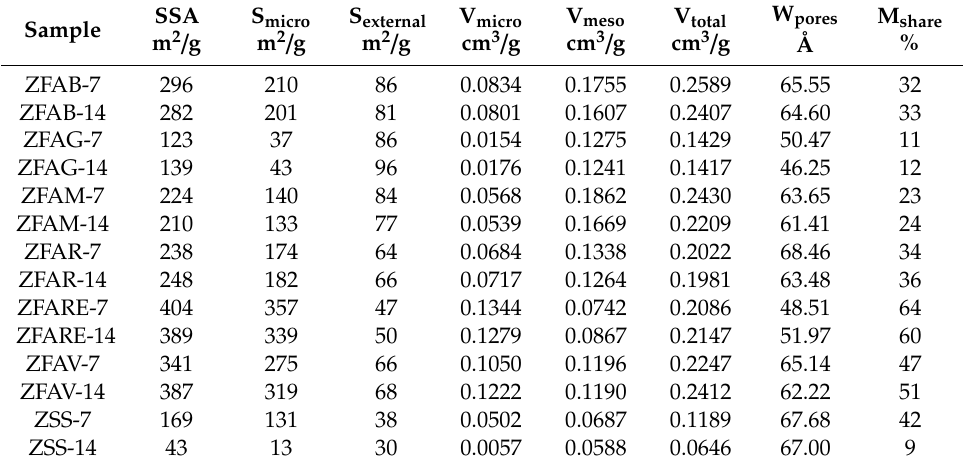
Table 2. Surface properties of FAZs calculated by the N 2 -adsorption / desorption experimental isotherms.